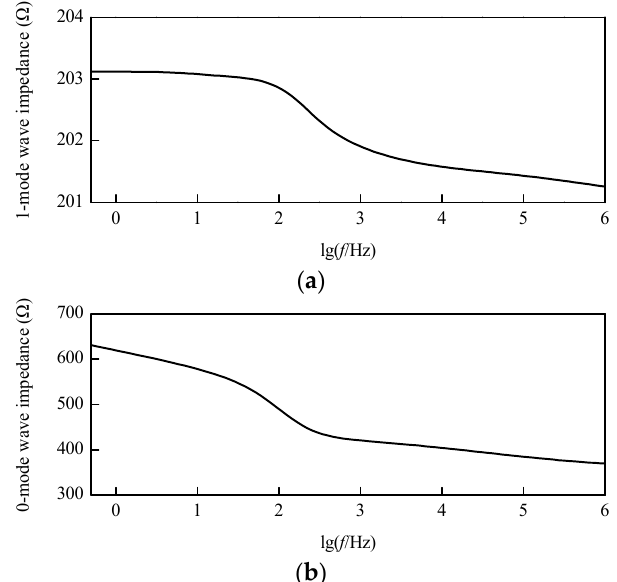
Figure 7. Modulus wave impedance characteristic curves: ( a ) 1-mode wave impedance; ( b ) 0-mode wave impedance.